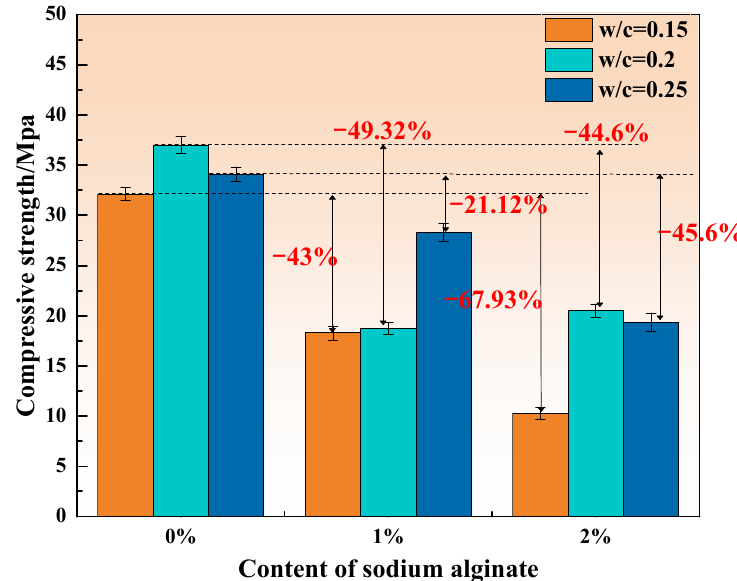
Figure 4. Compressive strength of the MKPCs after 1 day of curing.